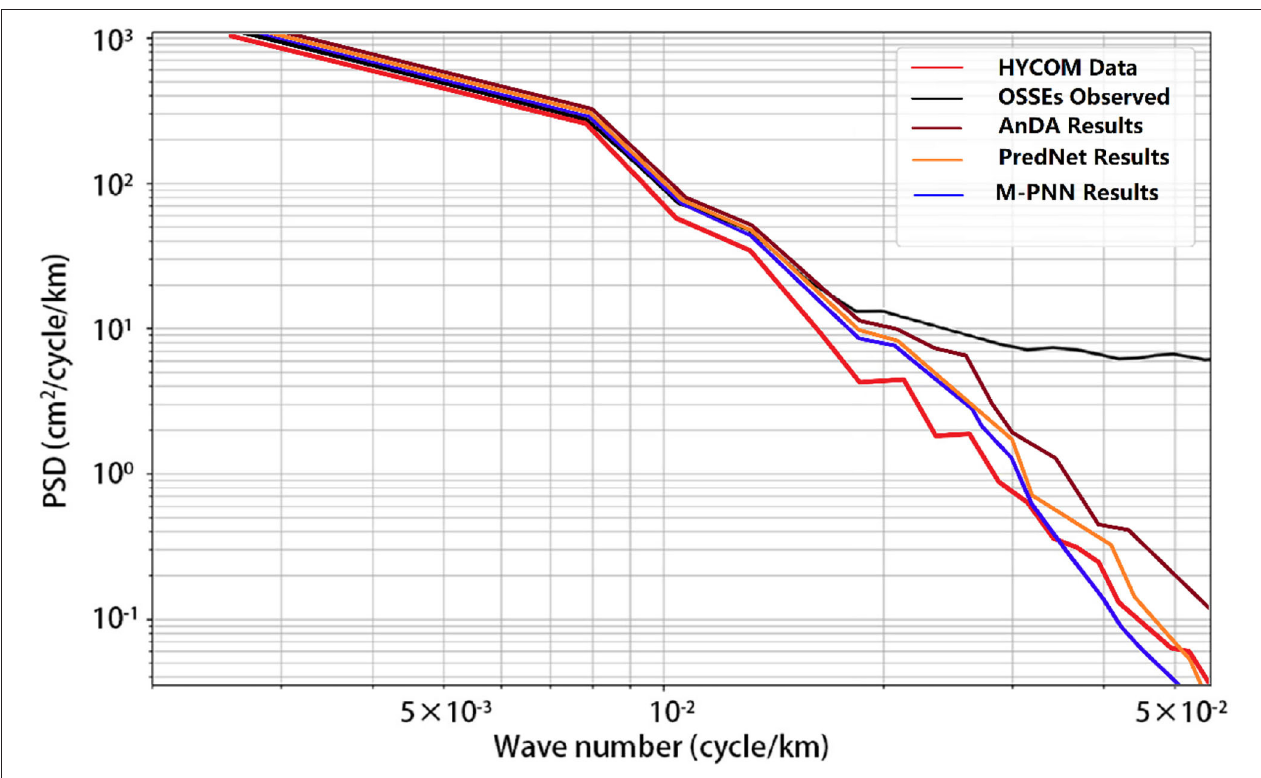
FIGURE 7 | The PSD of the AnDA, the PredNet, and the Mapping-PNN (M-PNN for short).